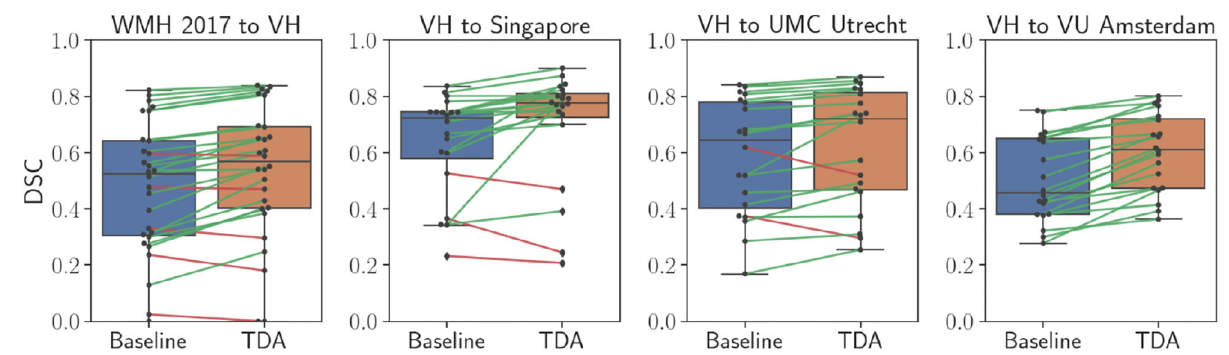
increasing the DSC from 0.410 to 0.536 ( p = 0.0002). The F- score was significantly improved from 0.270 to 0.308 ( p =